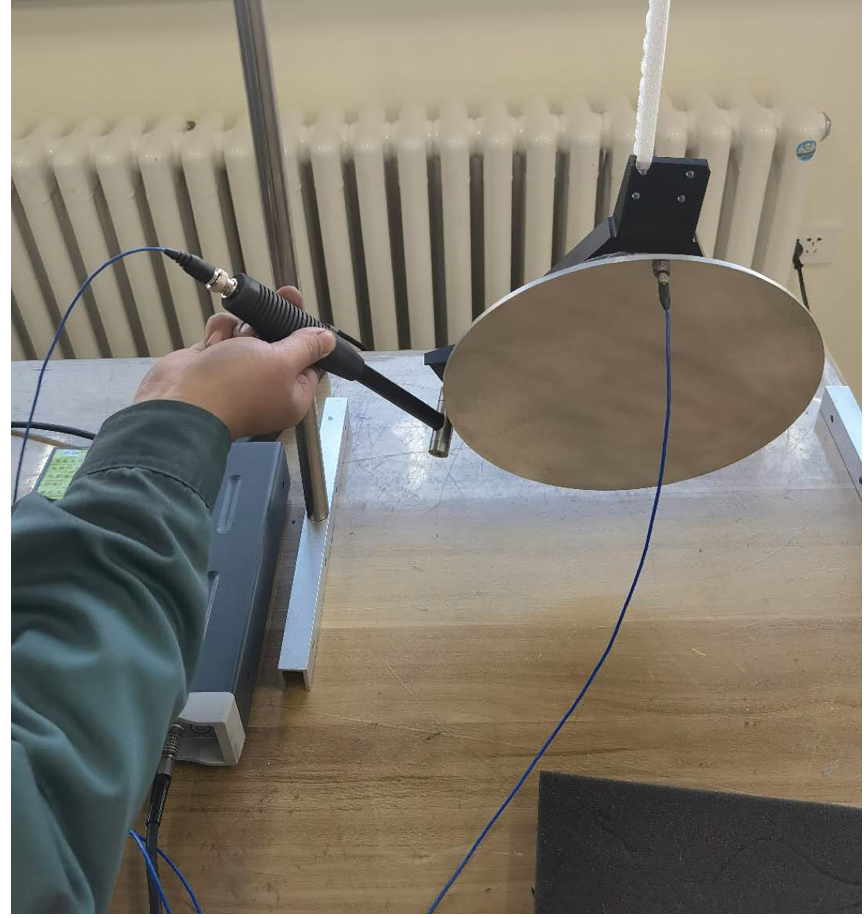
Figure 12. Test status of mirror modal frequency. Table 5. Comparison of mirror modal test results and analysis